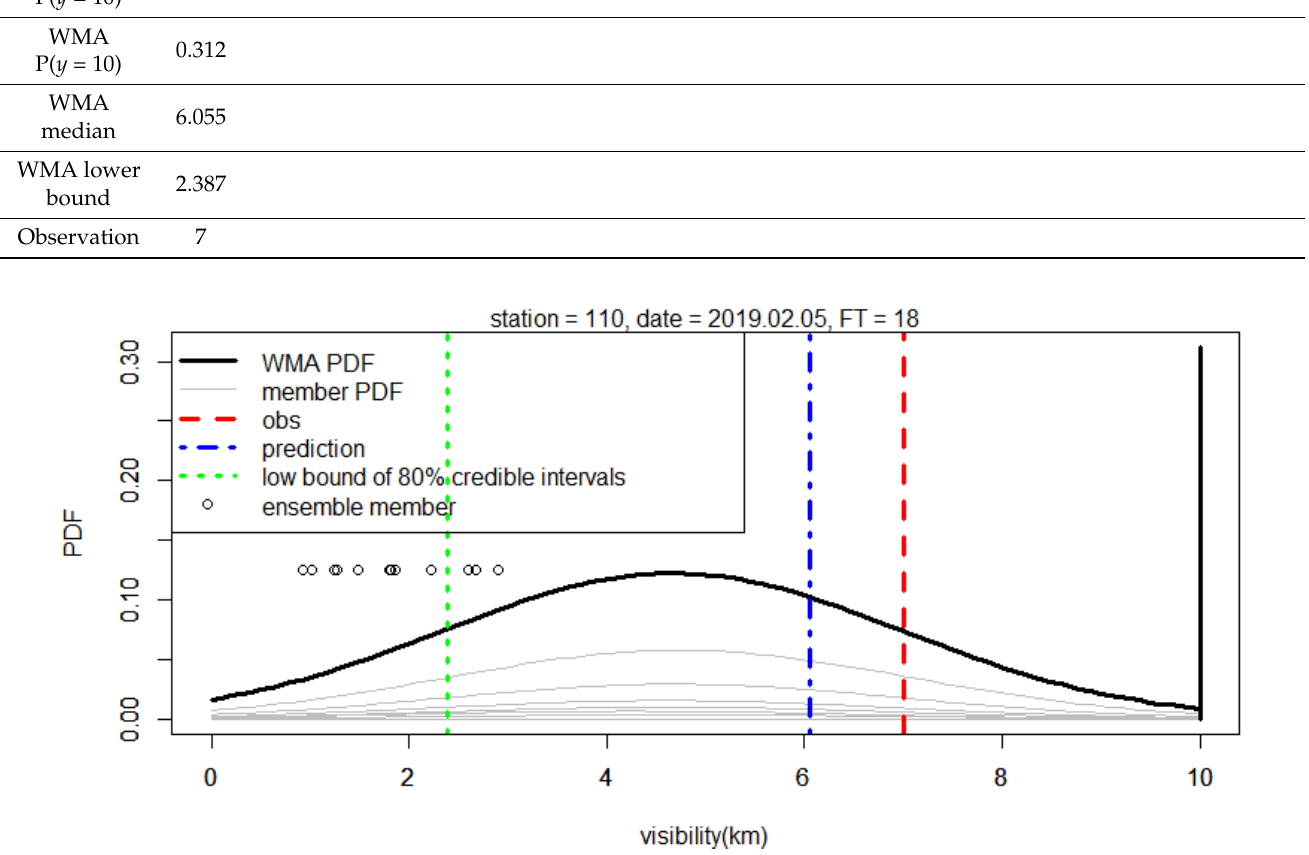
Figure 3. An example of WMA predictive probability density function (PDF) for Station 110. The vertical line at 10 km represents the WMA probability of visibility of 10 km. The vertical line (red) is the verifying observation; the blue vertical line is the WMA forecast; and the green vertical line is the 10th percentile of the WMA predictive PDF. The thick curve is the WMA predictive PDF of visibility given that it is less than 10 km, and the thin curves represent the individual ensemble contributions toward WMA. Dots represent the ensemble member forecasts.